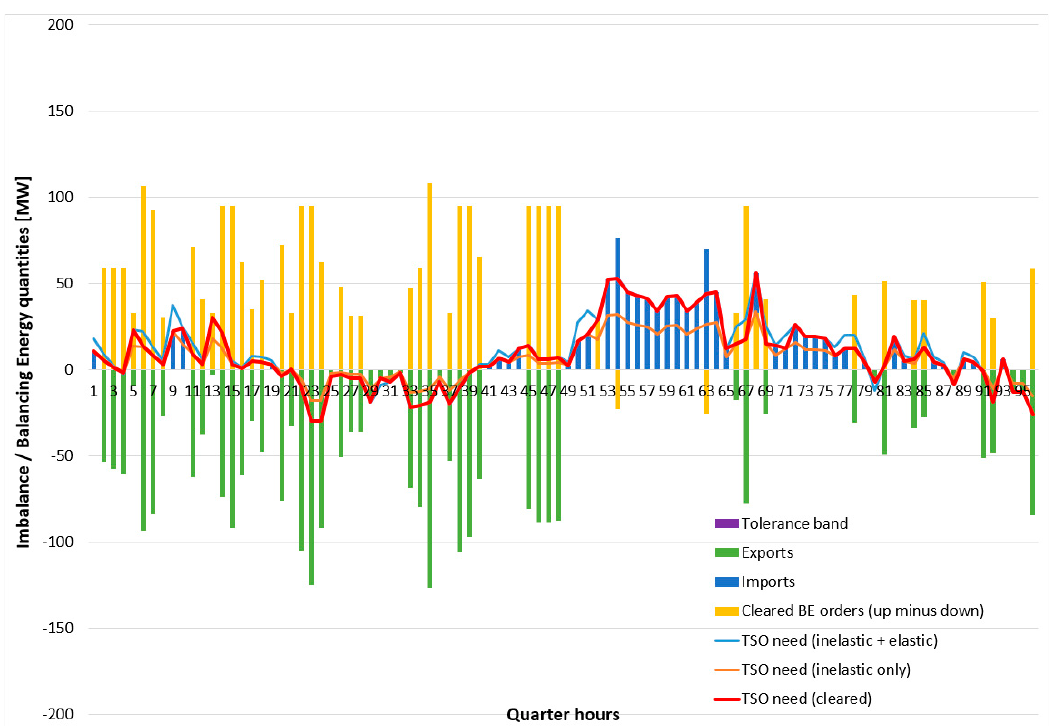
Figure 14. Clearing results per RTU for Switzerland.